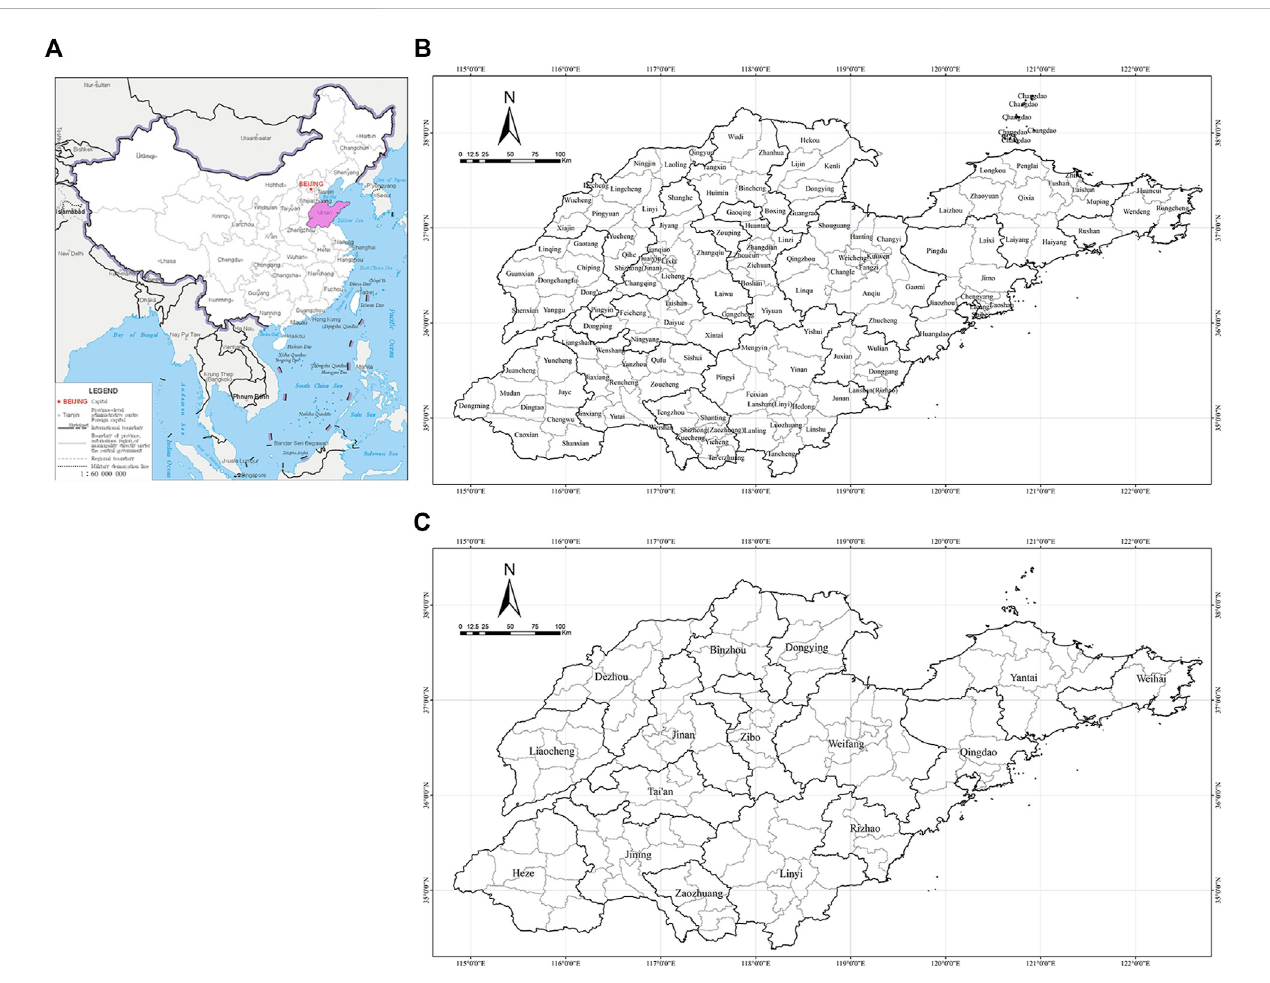
FIGURE 1 Study area: (A) the location of Shandong province in China; (B) Distribution of Prefecture-Level Cities in Shandong; (C) Distribution of County-Level Administrative Units ( “ city/cities ” in this study) in Shandong.